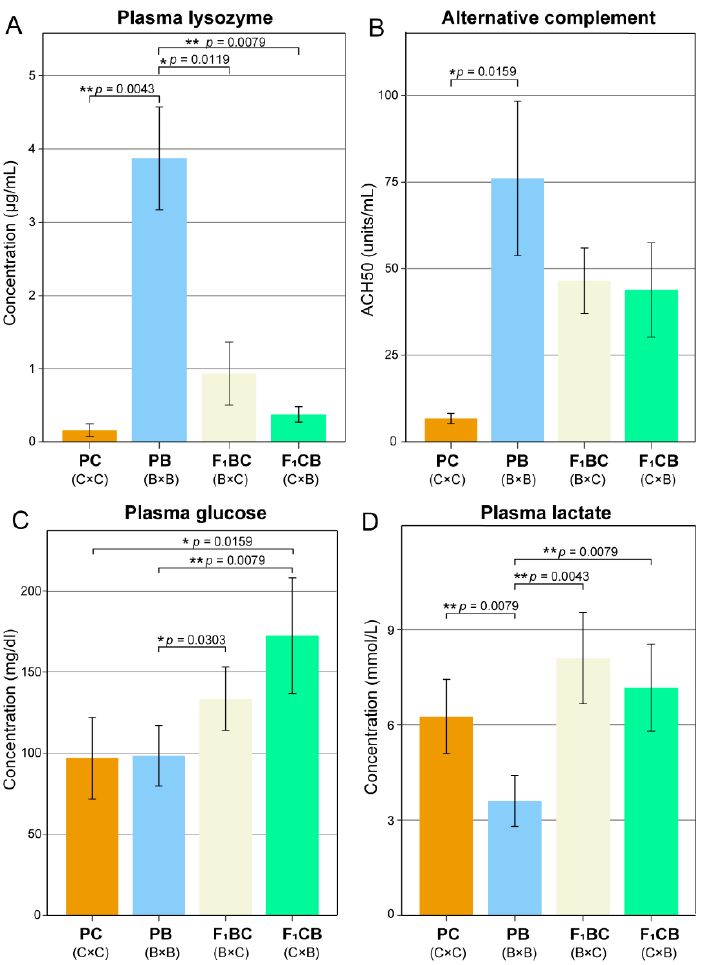
Figure 2. Plasma biochemical and immunological measurements in channel catfish (C), Ictalurus punctatus , blue catfish (B), I. furcatus, and their reciprocal F 1 hybrids raised in the tank environment. Plasma lysozyme activity ( A ); alternative complement pathway hemolytic activity ( B ); plasma glucose level ( C ); and plasma lactate level ( D ) were measured in channel catfish parental cross (PC), blue catfish parental cross (PB), blue catfish female × channel catfish male hybrids (F 1 BC), and channel catfish female × blue catfish male hybrids (F 1 CB). Statistical significance was assessed by non-parametric Mann–Whitney U test (*, p < 0.05; **, p < 0.01).The different colors representing the four genetic types were used consistently in this and subsequent figures.